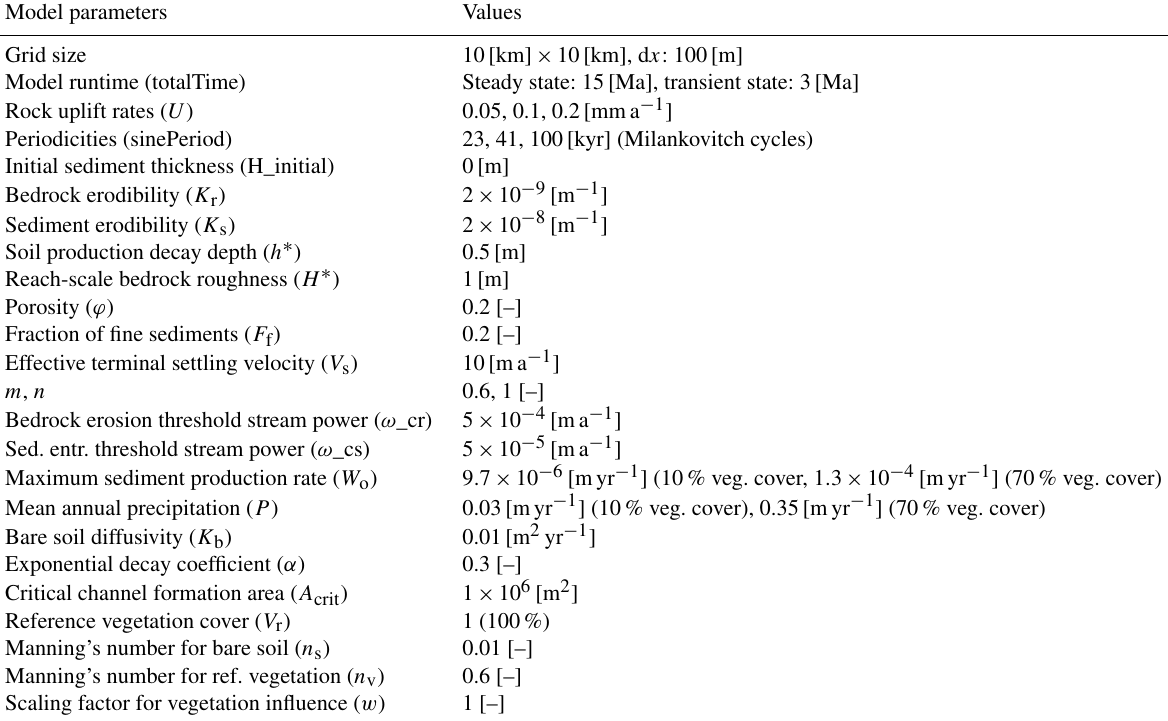
Table A1. Landscape evolution model input parameters used and corresponding